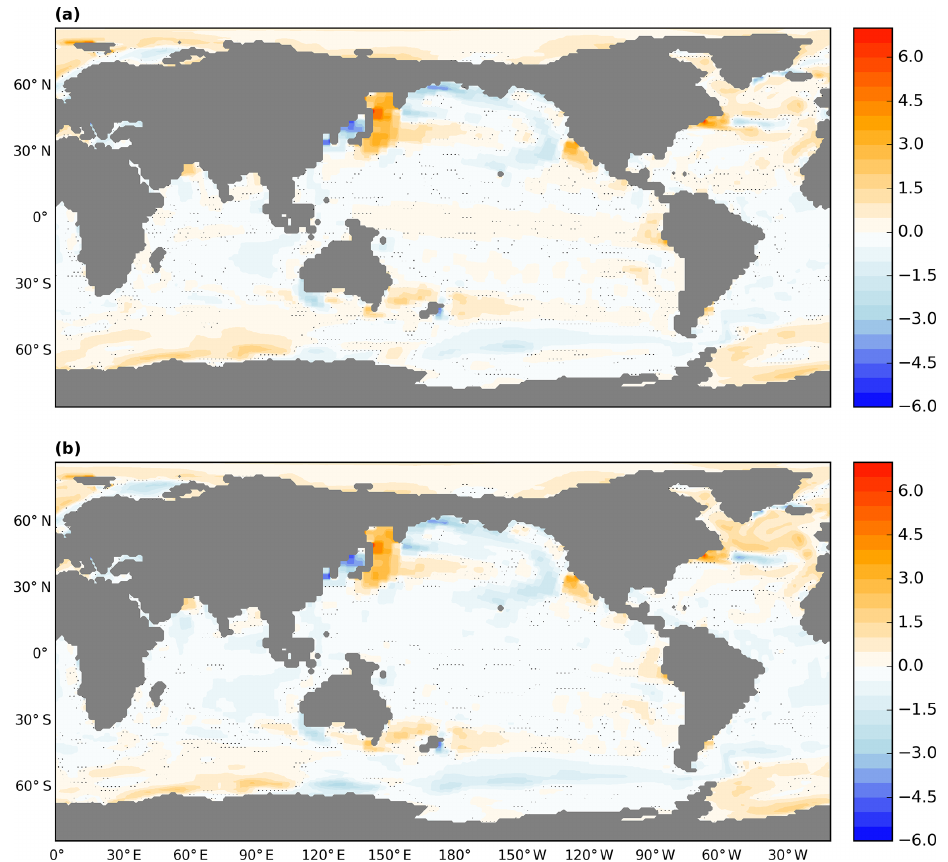
Figure 8. Annual mean SST ( ◦ C) anomalies between mid-Pliocene simulations with varying boundary and initial conditions. (a) Eoi405_ORB − PlioM1, which shows the contribution of changes in mid-Pliocene paleogeography between PlioMIP1 and PlioMIP2; (b) Eoi400 − PlioM1, comparing mid-Pliocene simulations of both phases of PlioMIP, incorporating all the changes in paleogeography, orbital, and greenhouse gas forcing from PlioMIP1 to